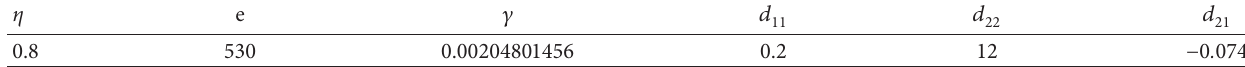
Table 7: Parameters set in system (4).